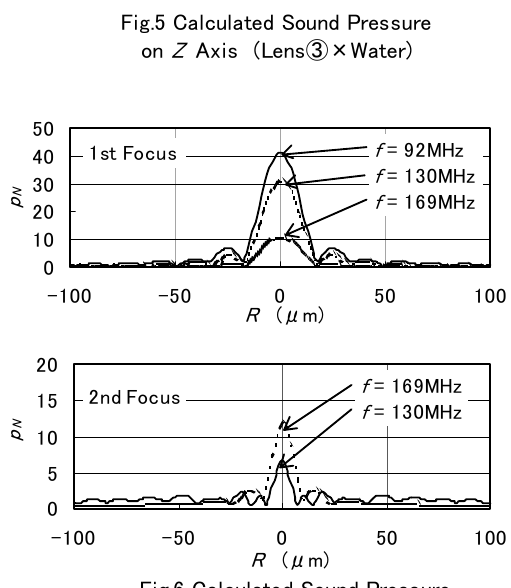
Fig.5 Calculated Sound Pressure on Z Axis (Lens③×Water)